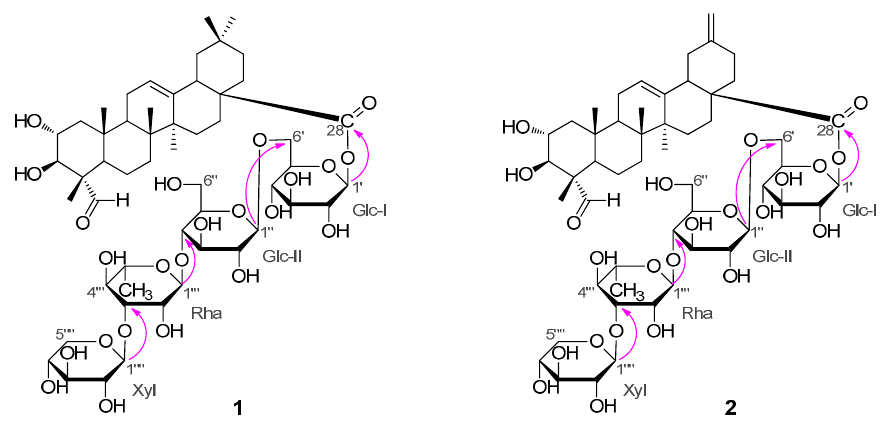
Figure 2. Selected HMBC correlations of compounds 1 and 2 .